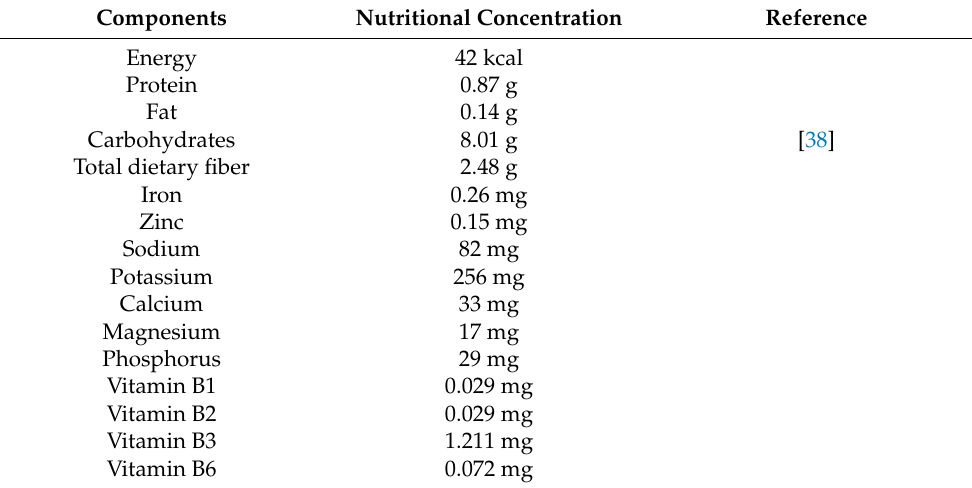
Table 1. The average nutritional values of purple carrot per 100 g.